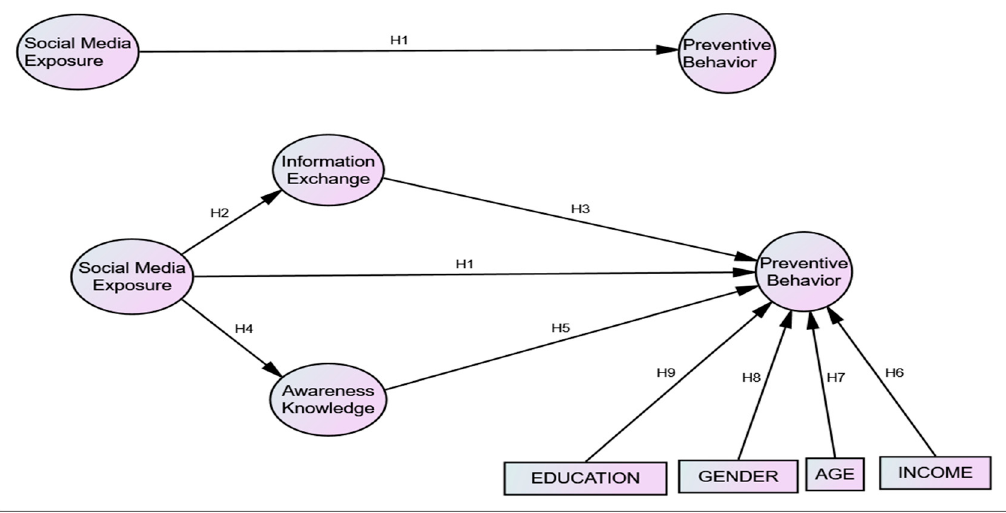
Figure 1. Conceptual Framework.